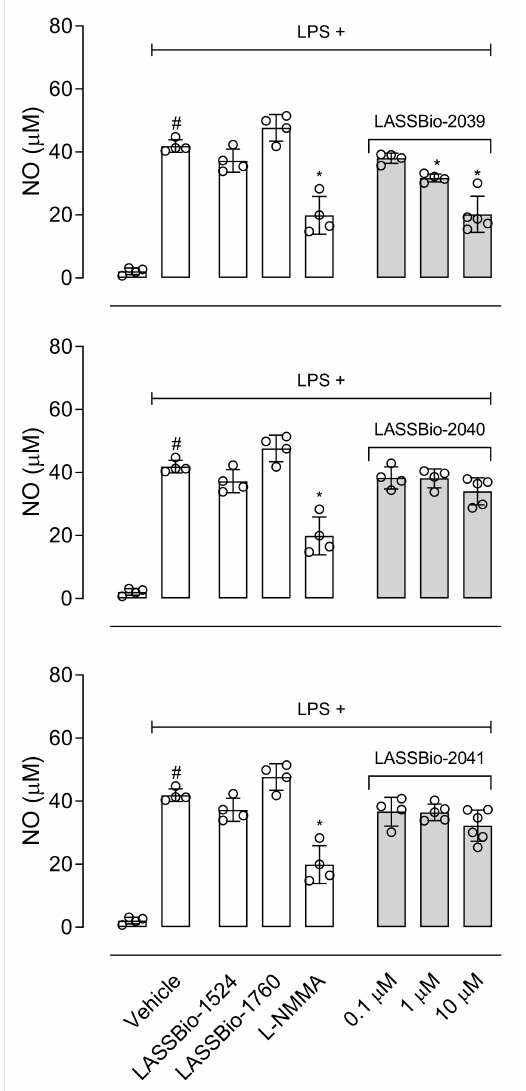
Figure 9. Effect of LASSBios in nitric oxide (NO) produced by J774.A1 cells line. Cells were incubated with vehicle, L-nitro mono methyl arginine (L-NMMA) or LASSBios (0.1, 1 or 10 µ M) and after 1 h were activated with LPS (1 µ g/mL). NO was measured 24 h later. Results are expressed as media ± SD ( n = 4–6). Where no error bar is shown is because it is smaller than the symbol. Statistical significance was calculated in GraphPad Prism 8.0 (San Diego, CA, USA) using analyses of variance (ANOVA) followed by Tukey post-test with p < 0.01 (#) when comparing LPS-activated cells treated with vehicle and non-activated cells treated with vehicle. p < 0.01 (*) when comparing LPS-activated cells treated with LASSBios and LPS-activated cells treated with vehicle. Data for the original compounds (LASSBio-1524 and LASSBio-1760) are original, independent duplicates of past results and have not been published